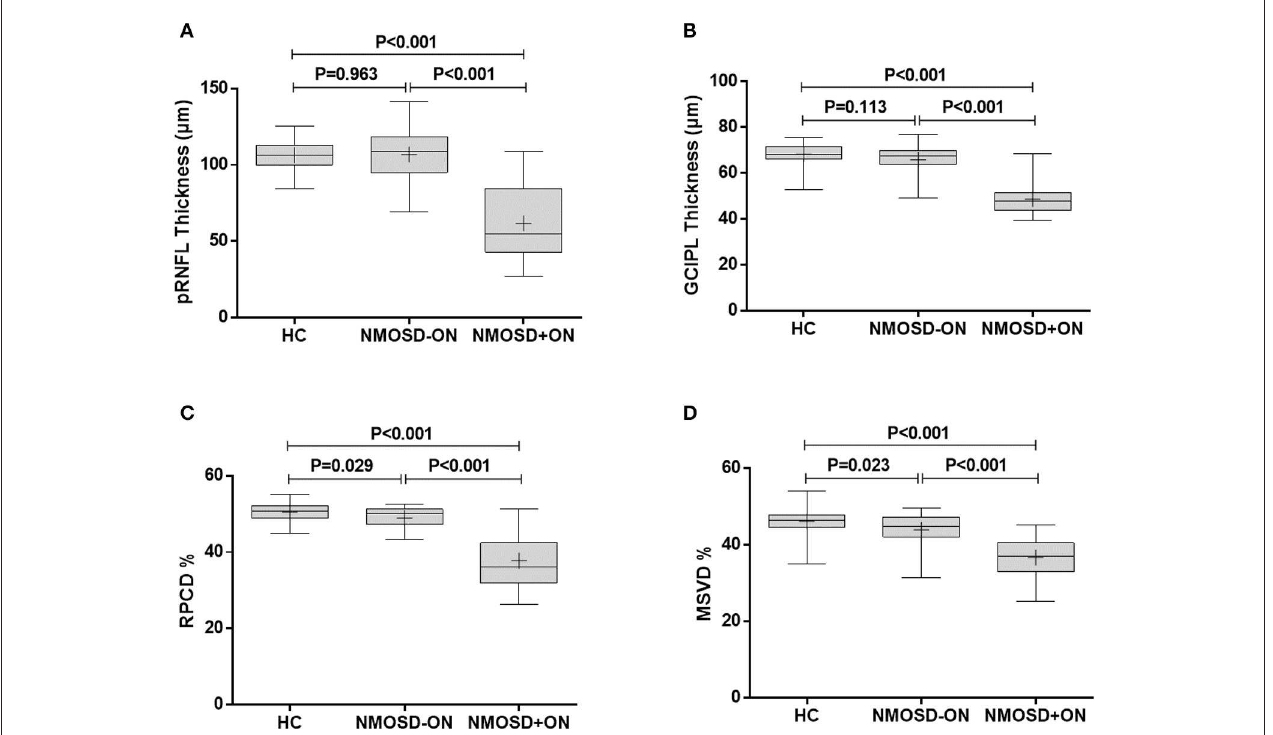
FIGURE 3 | Comparison of retinal thickness and vascular density between NMOSD and HC. (A) The comparison of pRNFL thickness, (B) GCIPL thickness, (C) RPCD, and (D) MSVD among the healthy control eyes, NMOSD eyes without a history of ON, and NMOSD eyes with a history of ON. HC, healthy control; NMOSD–ON, neuromyelitis optica spectrum disorders without optic neuropathy; NMOSD + ON, neuromyelitis optica spectrum disorders with optic neuropathy; pRNFL, peripapillary retina nerve fiber layer; GCIPL, ganglion cell layer and inner plexiform layer; RPCD, radial peripapillary capillary density; MSVD, macular superficial vessel density. Box, the upper quartile to the lower quartile values; + , mean value; bar inside box, median value; vertical lines, maximum and minimum